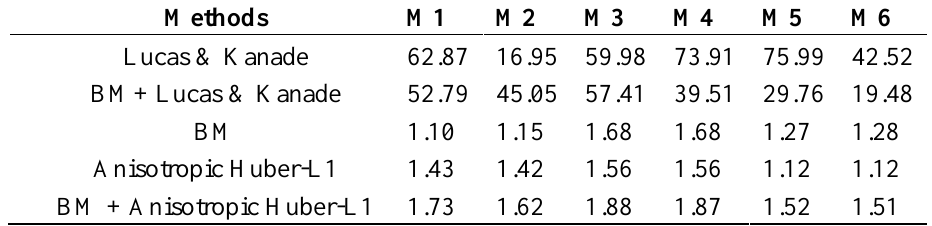
Table A1. Longitudinal error results after being evaluated with different methods.